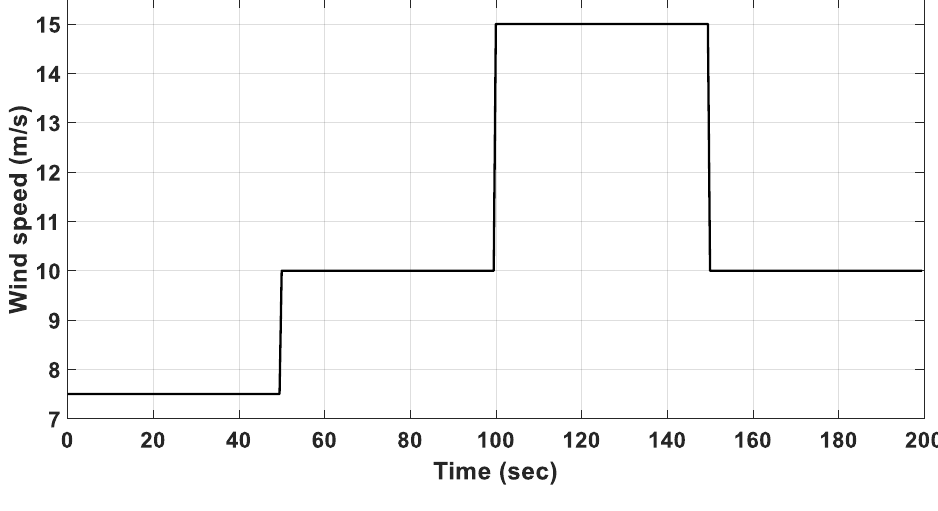
Figure 5. Gradient wind speed.